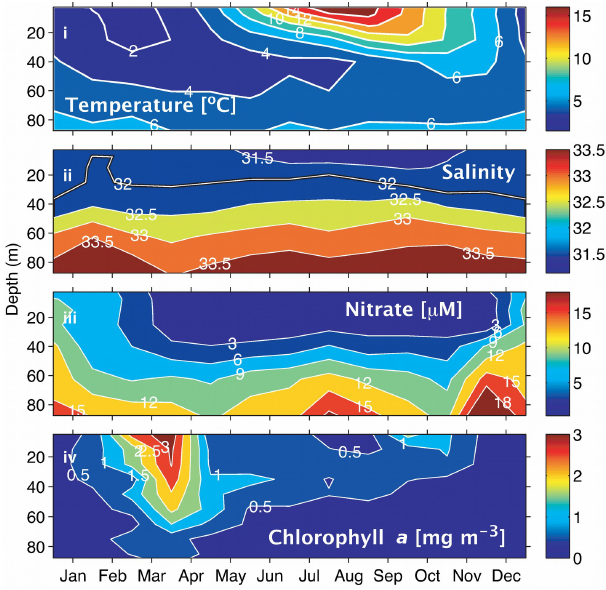
Figure 2. Climatologies for the Scotian Shelf observed at station HL2 (44.299 ◦ N 63.247 ◦ W). (i) Temperature, (ii) salinity, (iii) ni- trate, and (iv) Chl a . Reprinted with permission from Shadwick et al. (2011).